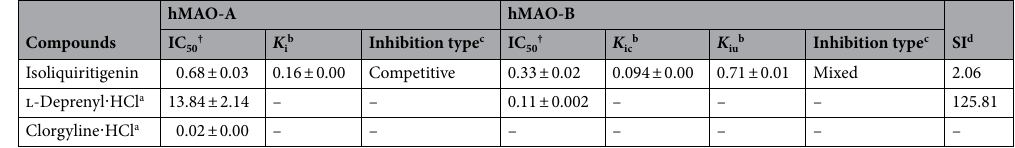
Table 1. Recombinant human monoamine oxidase (hMAO) inhibitory activity of isoliquiritigenin and its enzyme kinetic parameters. ND: not determined; (–): not tested. † The IC 50 value (μM) was calculated as mean ± standard deviation of triplicate assays. a Positive control, expressed as µM. b The hMAO inhibition constants ( K i ) were obtained from secondary plots. c hMAO inhibition type was determined using Lineweaver– Burk and Dixon plots. d The selectivity index (SI) was determined as the ratio of IC 50 for hMAO-A inhibition to IC 50 for hMAO-B inhibition.